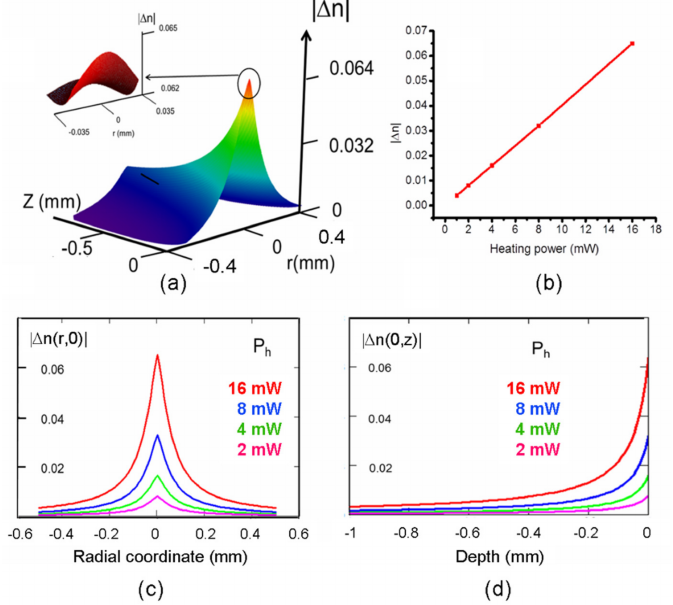
Figure 3. Results of the thermo − optical modeling. ( a ) Spatial variation of the refractive index due to the thermo-optical effect. In the inset, the apex distribution is shown. ( b ) Variation of | ∆ n(0,0)| with the heating power. ( c ) Radial distribution of the modulus on the graphene layer surface for several heating powers and ( d ) its axial distribution for the same